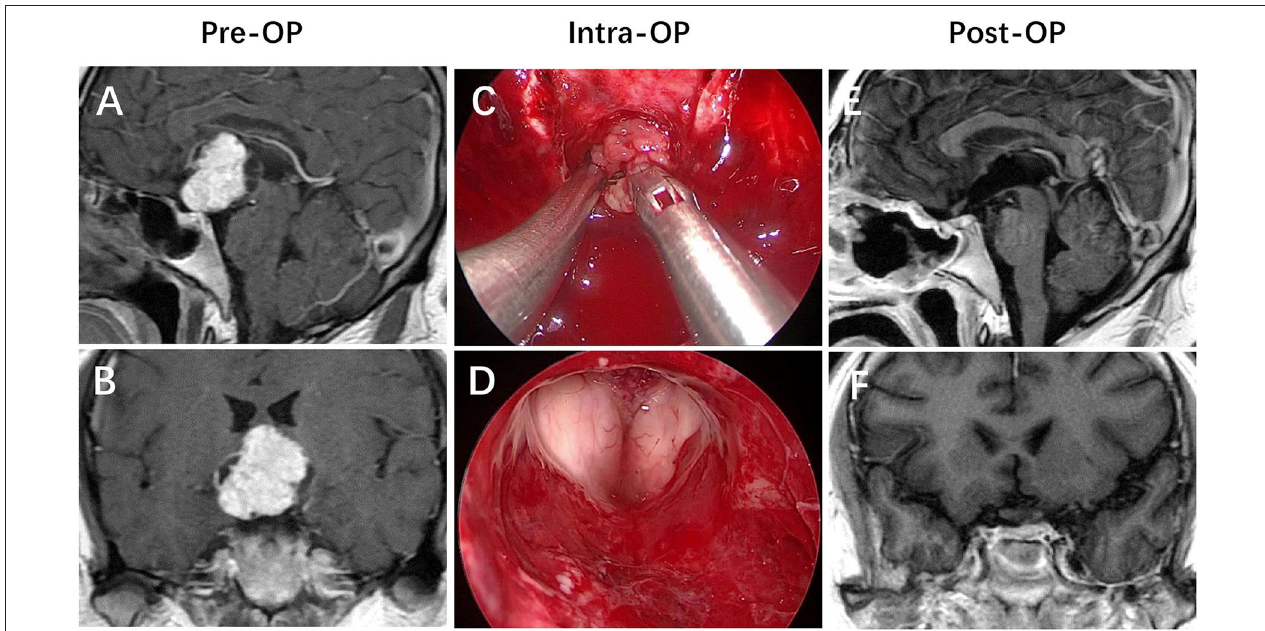
FIGURE 2 | Not strictly intraventricular craniopharyngioma. (A,B) Preoperative enhanced MRI demonstrated that a mass had primarily developed within the neural tissue of the third ventricle floor (TVF), progressively replacing part of the floor while expanding into the third ventricle cavity, in which expansion of the tumor has breached the TVF. (C,D) Intraoperative views revealed that the patient achieved a gross-total resection of the lesion via the endonasal endoscopic endonasal infrachiasmatic corridor. (E,F) Postoperative enhanced MRI revealed that the lesion was totally removed, with the posterior wall of the third ventricle and the pituitary stalk preserved intactly.